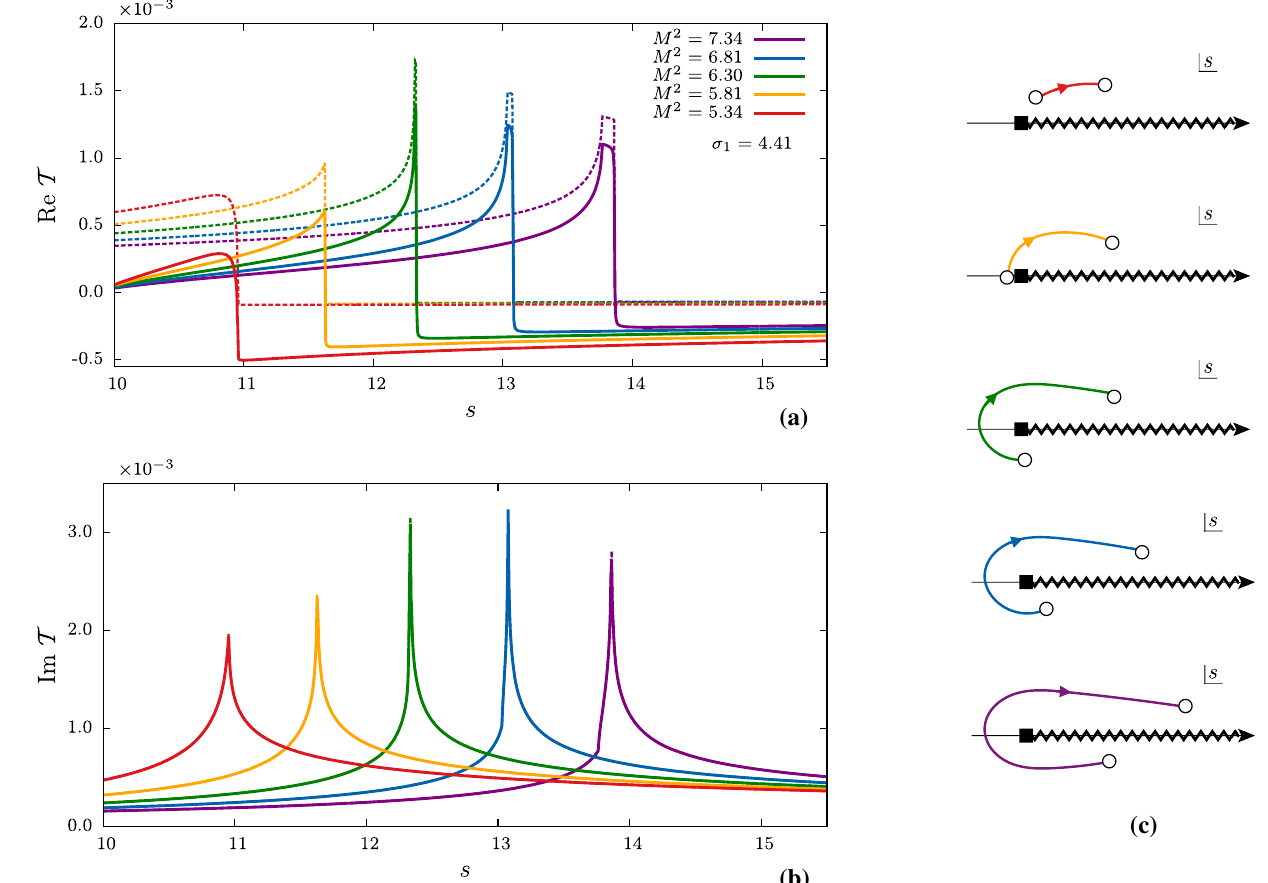
Fig. 17 The Feynman triangle Eq. (56) and the B -matrix triangle Eq. (54) in the vicinity of the triangle singularity for fixed σ 1 = 4 . 41 and varying M 2 in the range 5 . 33 ≤ M 2 ≤ 7 . 34. T B is shown with solid lines, T F is shown with dashed lines. Real parts are shown in a and imaginary parts in b . The imaginary parts for T F and T B coincide